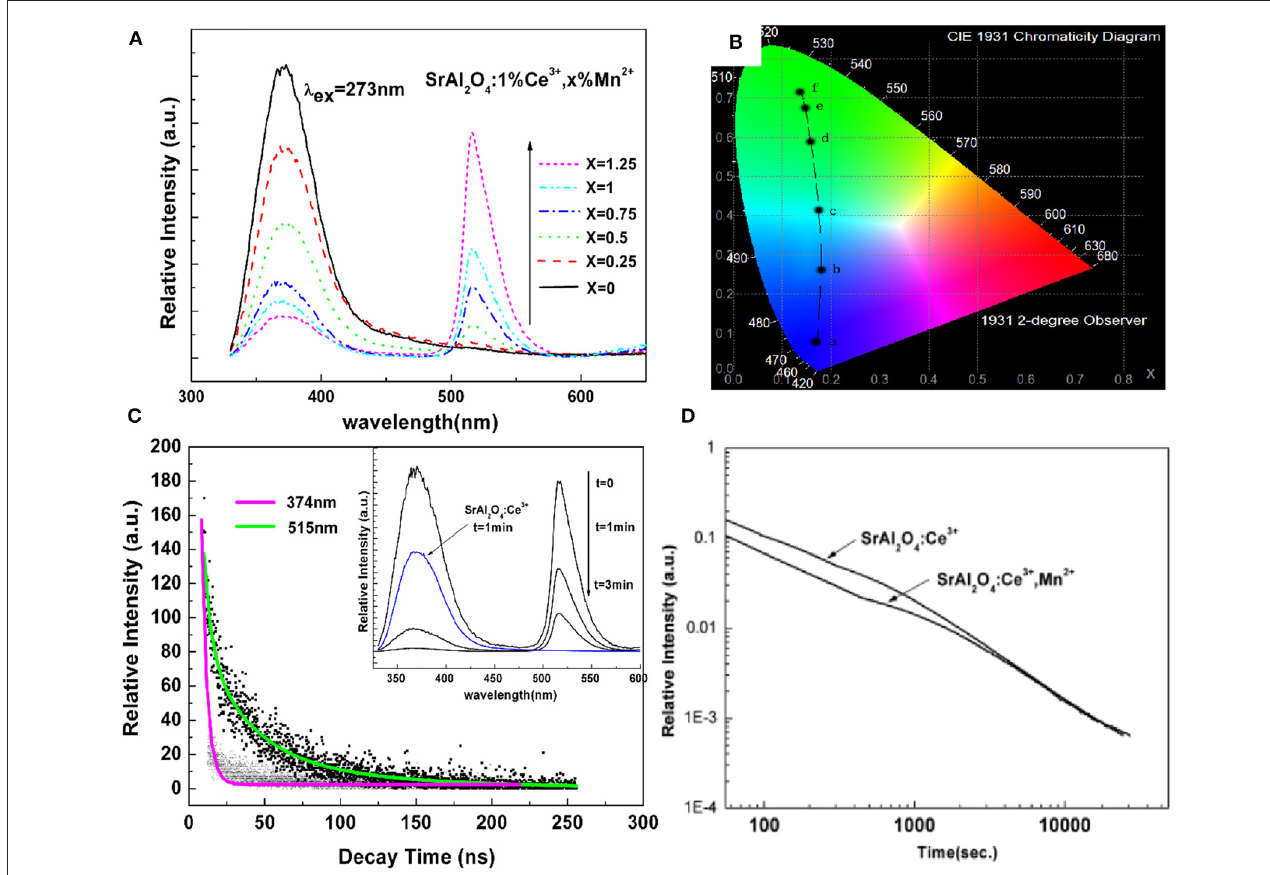
FIGURE 5 | (A) Emission spectra, and (B) CIE chromaticity diagram for SrAl 2 O 4 : 1% Ce 3 + , x% Mn 2 + ( x = 0, 0.25, 0.5, 0.75, 1, and 1.25) excited by 273nm. (C) Lifetime decay curves of 370 and 515nm emissions in SrAl 2 O 4 : 1%Ce 3 + , 0.75%Mn 2 + phosphor. Inset: the LPL spectra of SrAl 2 O 4 : 1%Ce 3 + , 0.75%Mn 2 + after switching off the excitation source at different times. (D) LPL decay curves of SrAl 2 O 4 : 1%Ce 3 + and SrAl 2 O 4 : 1%Ce 3 + , 0.75%Mn 2 + after 10min excitation of artificial light. Reprinted with permission from Xu et al. (2011). Copyright (2010) The American Ceramic Society.